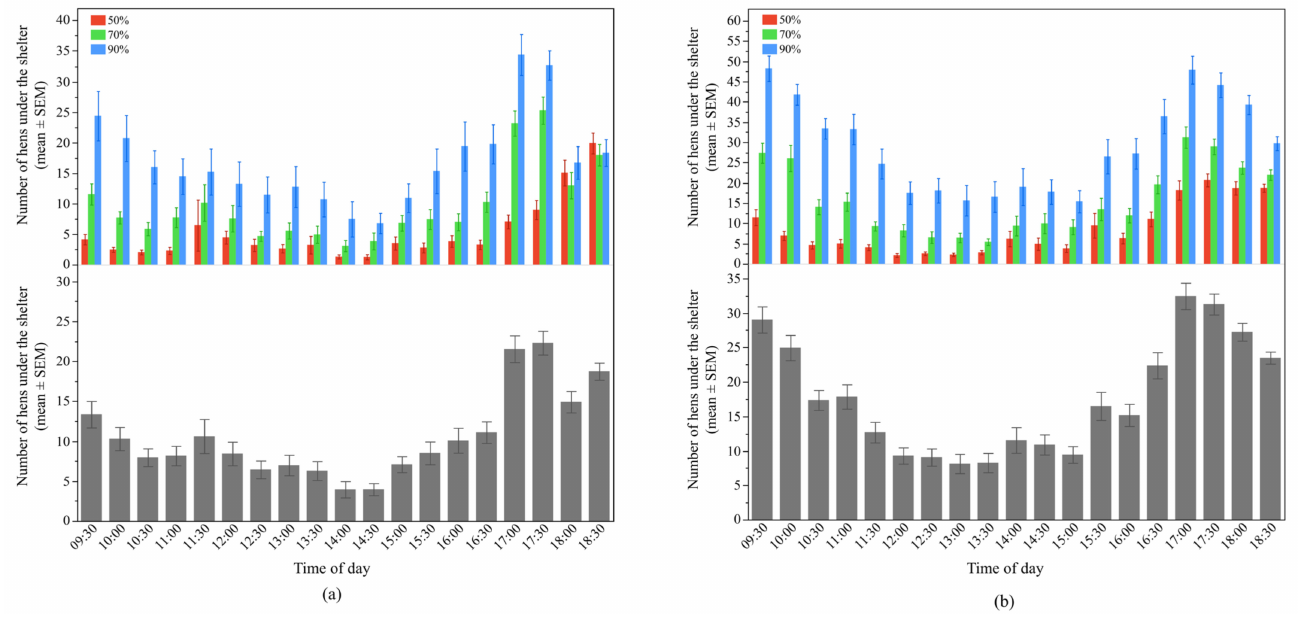
Figure 3. The mean ( ± SEM) number of hens underneath the shelters during the day: ( a ) Flock-A: with different UV-filtering percentages (50%, 70%, and 90%) ( top ), under all UV-filtering shelters ( bottom ); ( b ) Flock-B: with different UV-filtering percentages (50%, 70%, and 90%) ( top ), under all UV-filtering shelters ( bottom ). Note the different Y-axis scales between Flock-A and Flock-B. Raw values are presented with analyses conducted on transformed